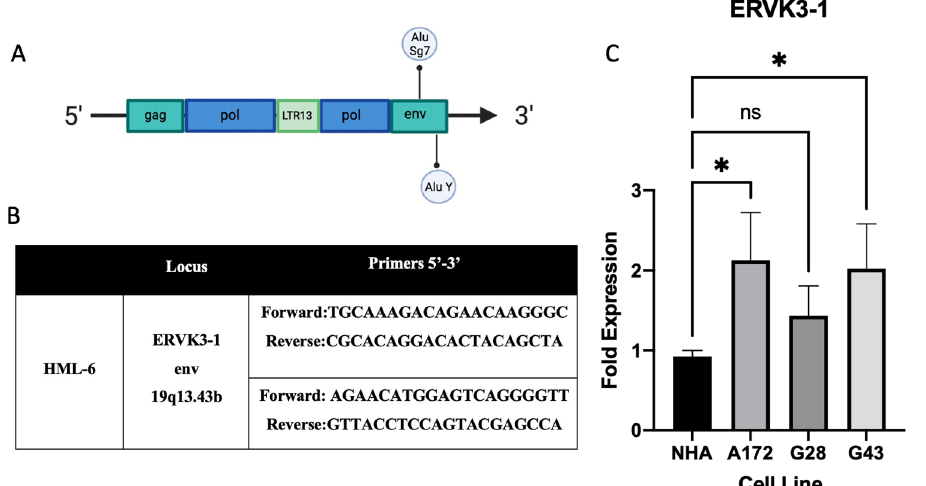
Figure 3. The HML-6 envelope transcript is overexpressed in GBM cell lines. ( A ) ERVK3-1 is located in the envelope region of the HML-6 provirus and encodes a small peptide (~ 140–190 amino acids). ( B ) Two sets of primers for the HML-6 provirus localize to the ERVK3-1 envelope region. ( C ) Quantitative Polymerase Chain Reaction (PCR) demonstrates significant overexpression of HML-6 in the adherent A172 glioblastoma cell line and patient-derived glioma neurosphere cultures (GBM 28 and GBM43). Data represents mean + SEM of triplicates and analyzed by multiple ANOVA. * p <